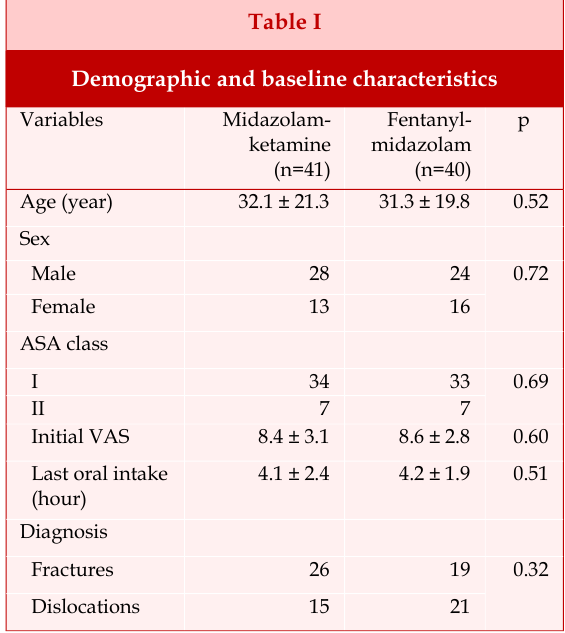
Figure 1: CONSORT flowchart of studied